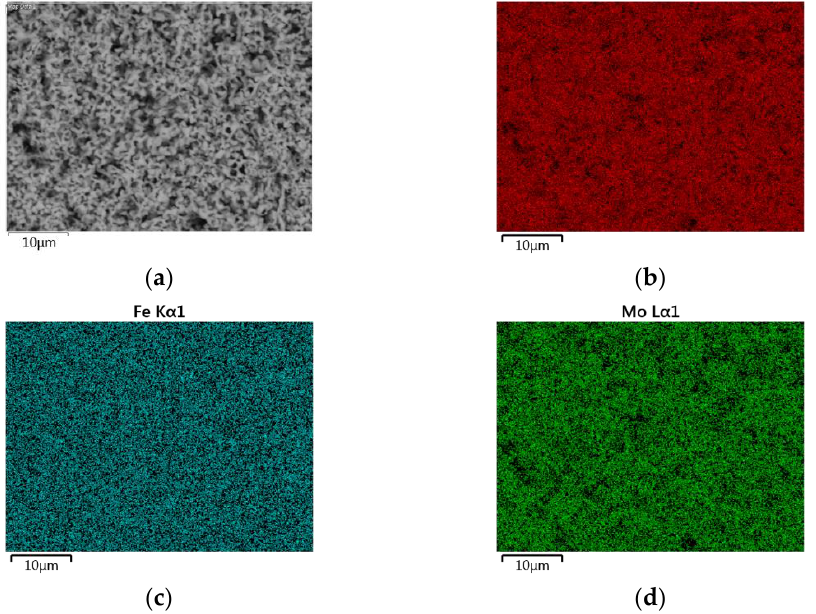
Figure 6. EDS mapping for a section of the sample SGA after the reduction process ( a ). A uniform distribution of strontium ( b ), iron ( c ), and molybdenum ( d ) atoms can be observed.